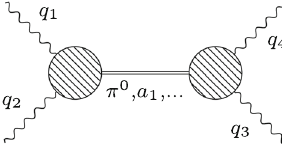
Fig. 4 Single-particle intermediate states in the hadronic HLBL tensor